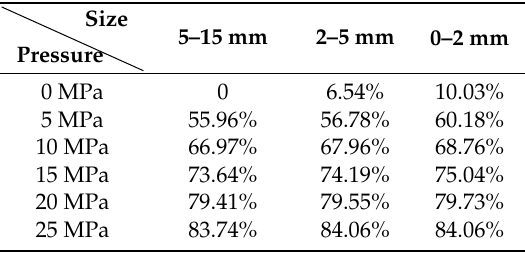
Table 5. Reduction rates of total porosity ( ∆ n t ) for each particle size class and